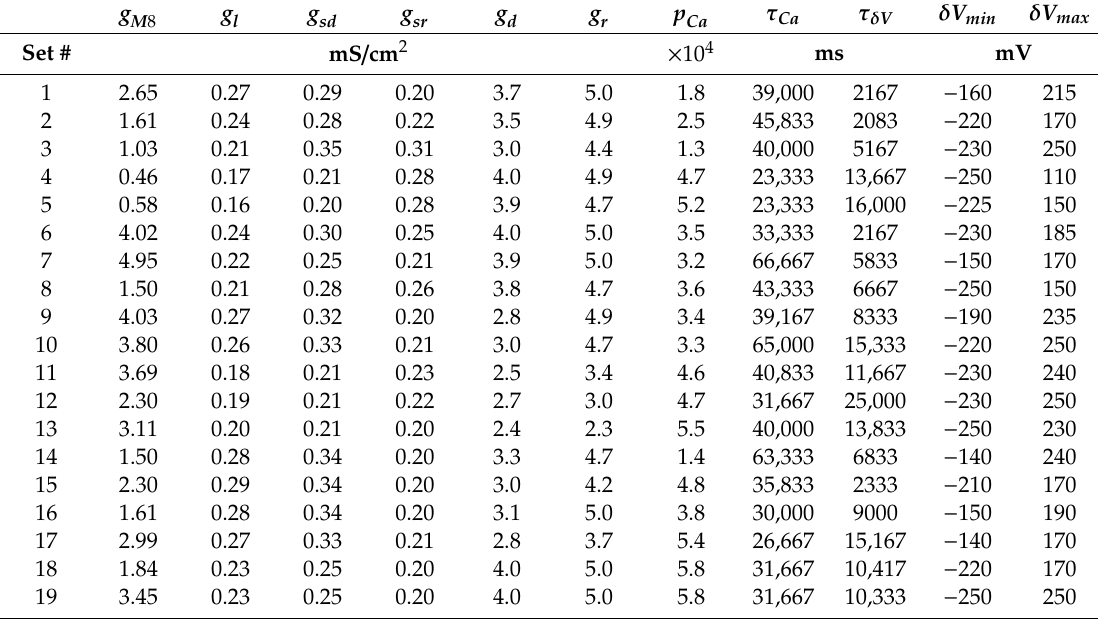
Table 1. Parameter sets used in the